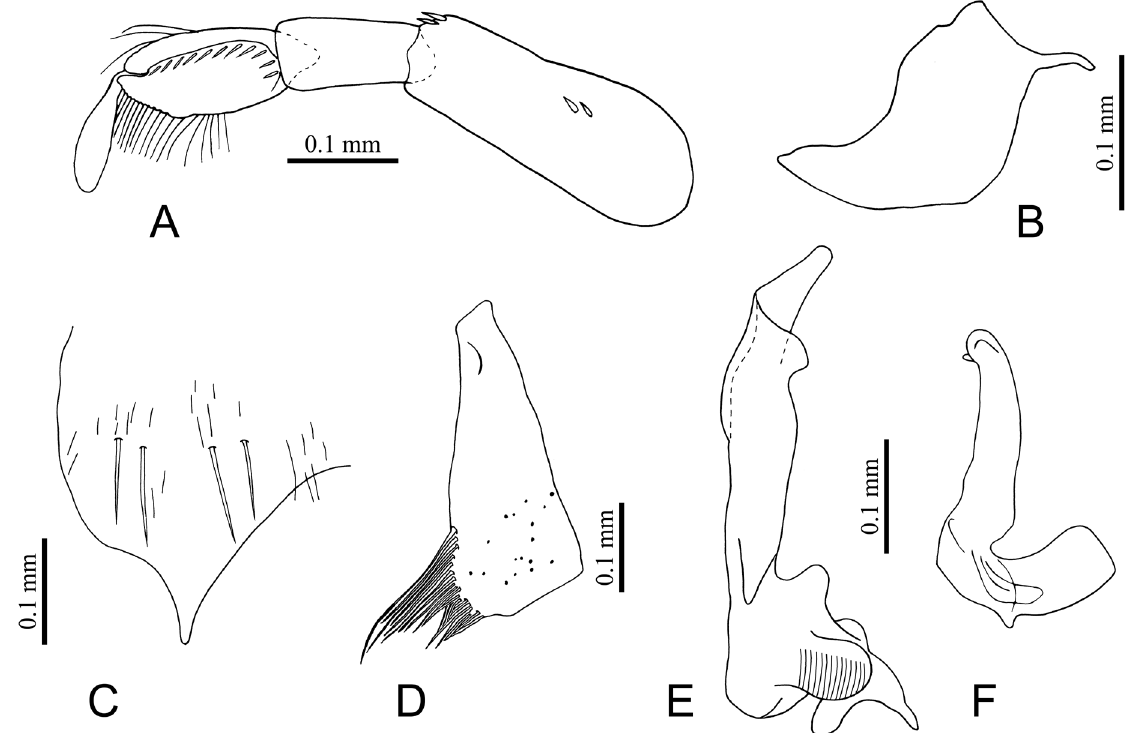
Fig. 16. Morphological features of Micronecta sinuata sp. nov., ♂, paratype (ZVNU). A . Fore leg. B . Prestrigilar flap. C . Median lobe of sternite VII. D . Free lobe. E . Right paramere. F . Left